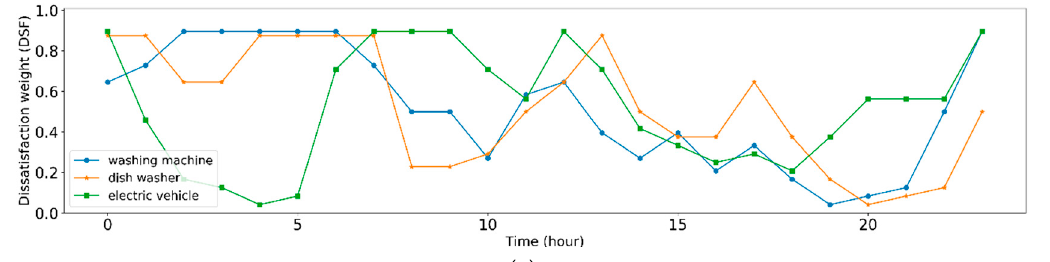
Figure 3. ( a ) Percentile rank compared to a normal bell-shaped curve [31]; ( b ) Result of percentile rank for 24 h with R t value.